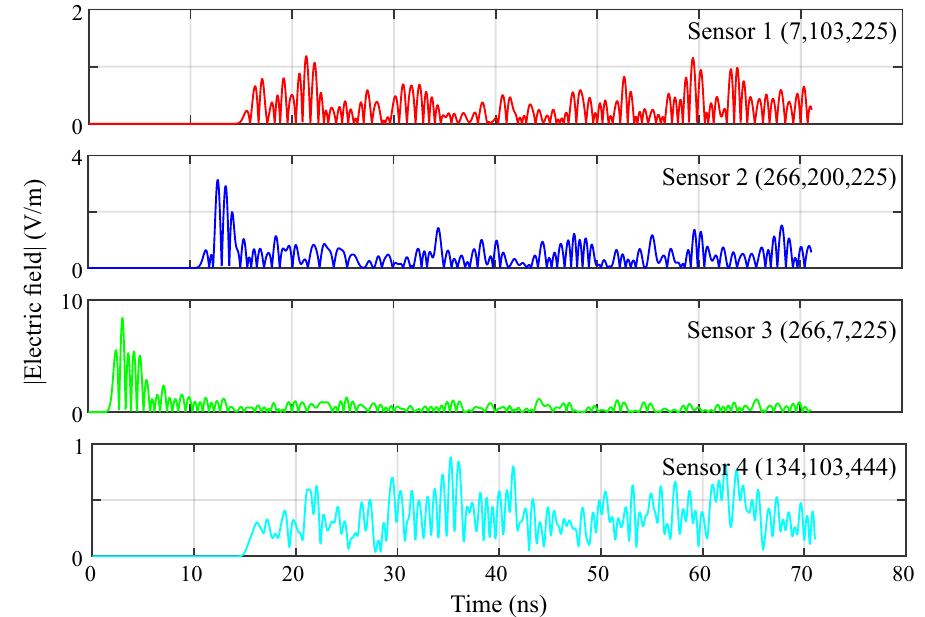
Figure 8. Magnitude of the signals obtained from the UHF sensors for the defect